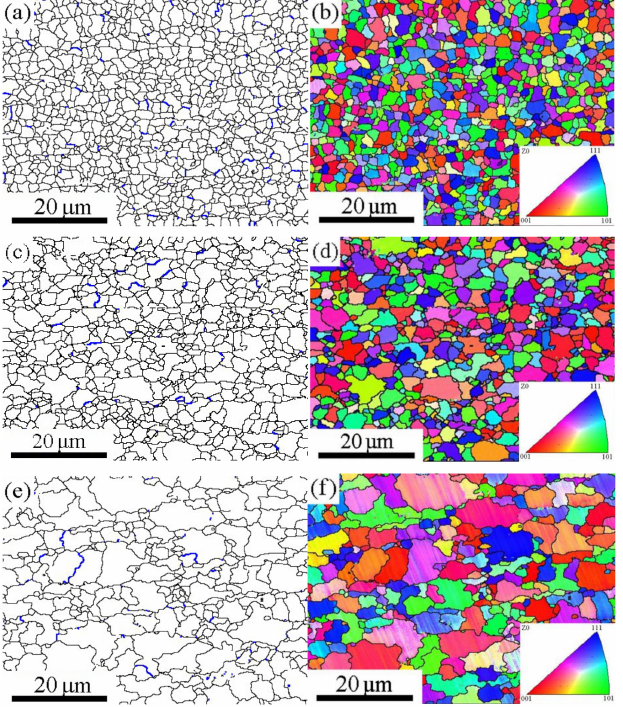
Figure 15. EBSD grain orientation maps of M50 steel under different deformation conditions: . . . ε = 1 s − 1 ; ( c , d ) T = 1100 ◦ C, ε = 0.01 s − 1 ; and ( e , f ) T = 1150 ◦ C, ε = 0.01 s − 1 . ( a , b ) T = 1100 ◦ C, ( a , c , e ) Kikuchi pattern quality maps (BC) of M50; ( b , d , f ) inverse pole figures (IPF) of M50 (the blue and black lines represent grain boundaries with misorientation angles ( θ ): 2–15 ◦ and >15 ◦ ,